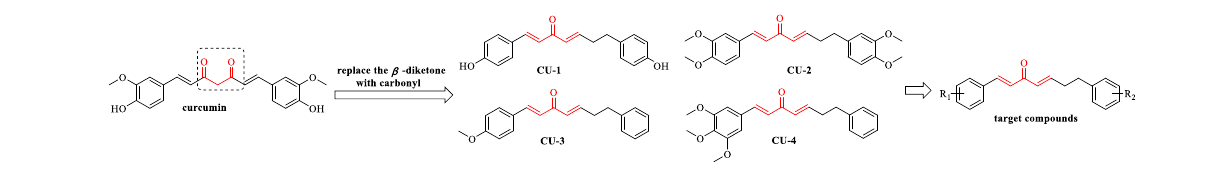
Figure 1. The structures of CU , some reported mono-carbonyl analogues, and the target compounds. Table 1. The structures of the target compounds.